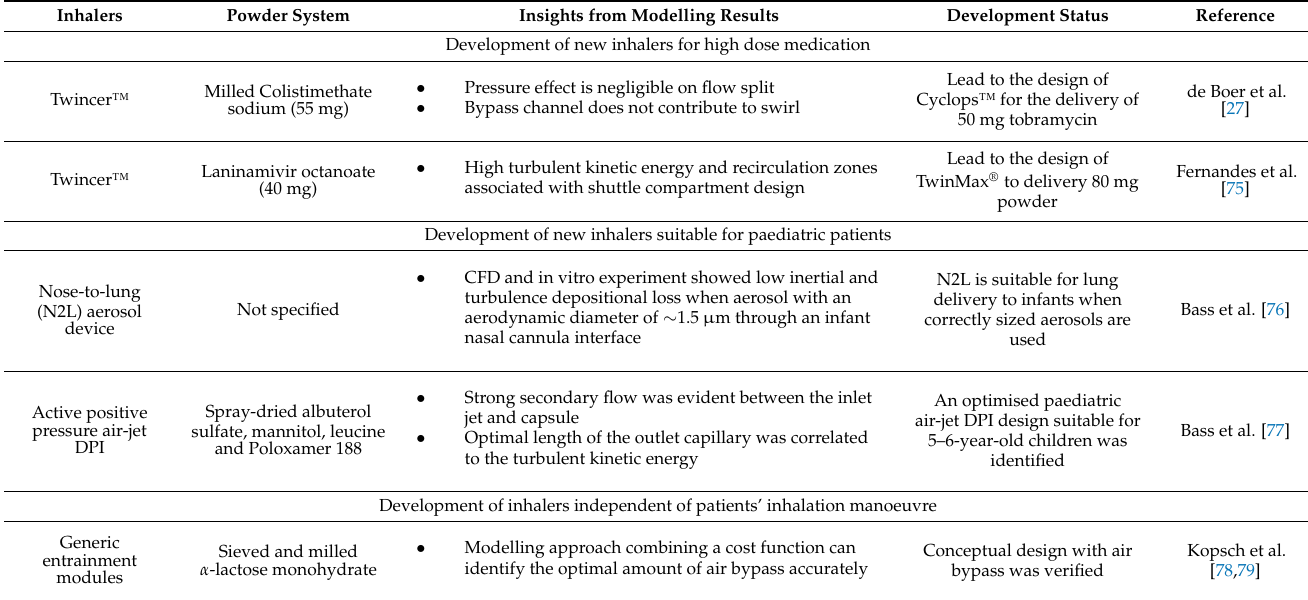
Table 3. Representative computational modelling studies for emerging DPI